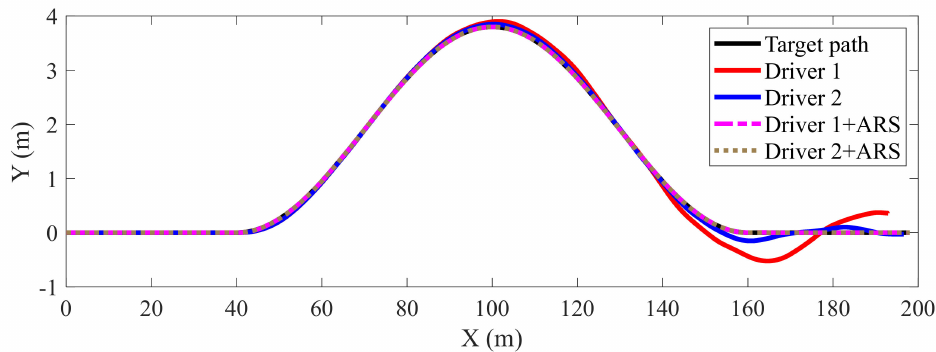
Figure 5. Moving trajectories of vehicles in Case